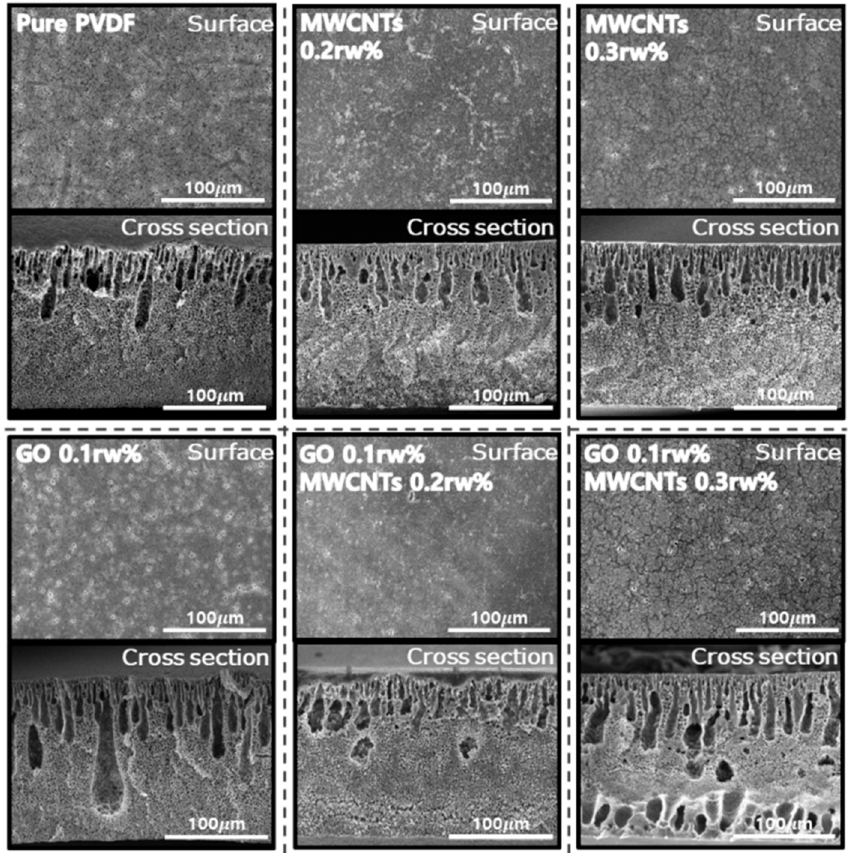
Figure 2. FE-SEM images of the bottom surface and cross-section for